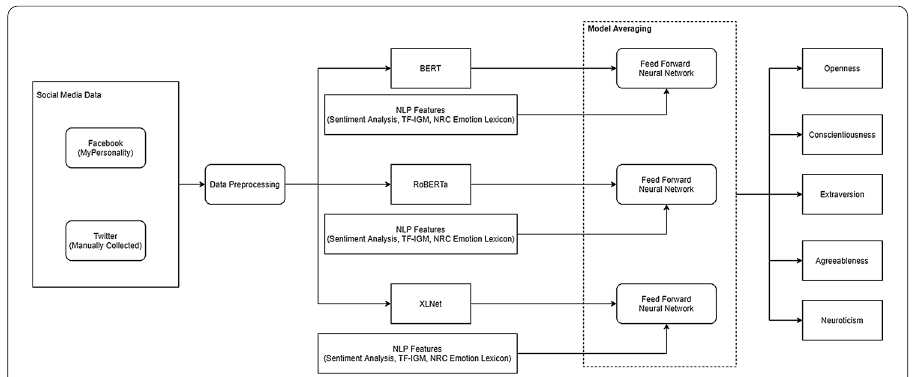
Fig. 1 Flowchart Conducted Methodology